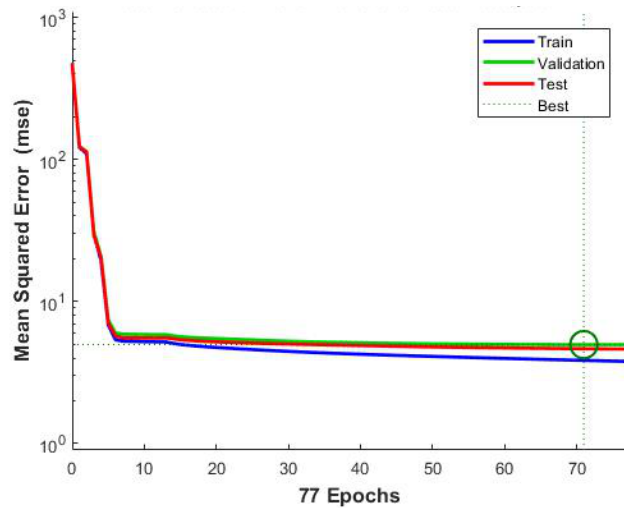
Figure 7. Training regression, Case 1.